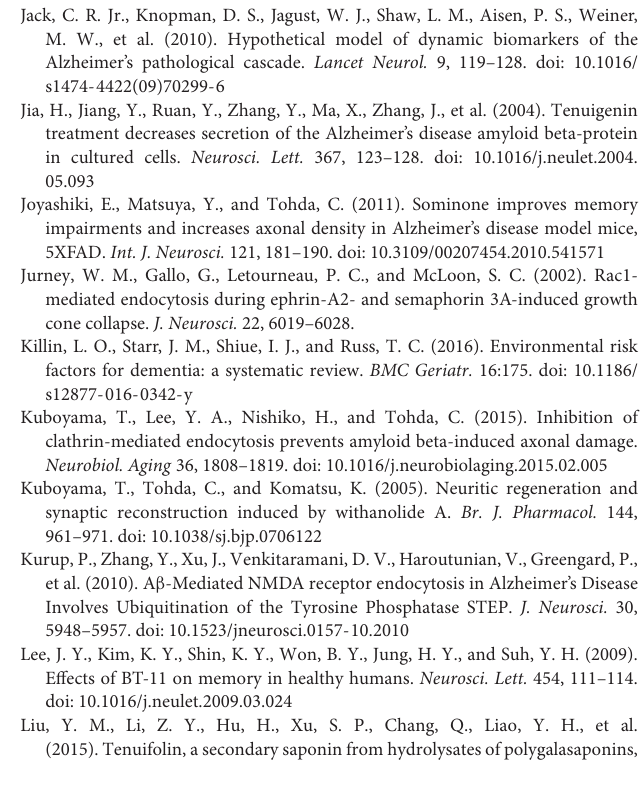
FIGURE S1 | High performance liquid chromatography (HPLC) profiles. Polygalae Radix (PR) extract and standard compounds were analyzed using two kinds of HPLC protocols, i.e., one to detect tenuifolin (A,B) and the other to detect of 3 (cid:48) ,6-di- O -sinapoyl sucrose ester (C,D) . HPLC profiles of PR extract (A,C) and standard compounds, tenuifolin (B) and 3 (cid:48) ,6-di- O -sinapoyl sucrose ester (D) , are shown. Arrows indicate peaks of tenuifolin (A,B) and 3 (cid:48) ,6-di- O -sinapoyl sucrose ester (C,D) , respectively. FIGURE S2 | Age-dependent phenotypes of 5XFAD mice. (A) Novel object recognition tests were performed as done in Figure 2 using WT and 5XFAD male mice at various ages. The numbers in parentheses indicate the age of the mice. Values of preferential indices of each mouse are shown. Paired t -test; n = 3 mice. (B,C) After the behavioral tests, the mice were euthanized and the brain sections were immunostained for phosphorylated neurofilament-H (pNF-H) and amyloid β (A β ). The density of A β plaques (B) and degenerated axons associated with the A β plaque (C) were quantified in the medial prefrontal cortex. The mean values of the data are presented together with the standard error. ∗∗∗ P < 0.001 vs. WT; Bonferroni’s multiple comparison test. n = 3 mice. FIGURE S3 | Changes in body weight and exploratory behaviors after the administration of PR extract. Vehicle solution (Veh) or PR extract [at doses of 12 or 60 mg/kg/day; PR (12), PR (60), respectively] were orally administered daily for 56 days to 4-month-old 5XFAD mice. (A) The mean values of the body weight of the mice are presented together with the standard error. There is no statistical difference among groups. P > 0.05; 2-way repeated measures ANOVA, n = 4–5 mice. (B) Total number of times the mice encountered the two objects in the open box was counted in the training session. There was no statistical difference among the groups. P > 0.05; 1-way ANOVA, n = 4–5